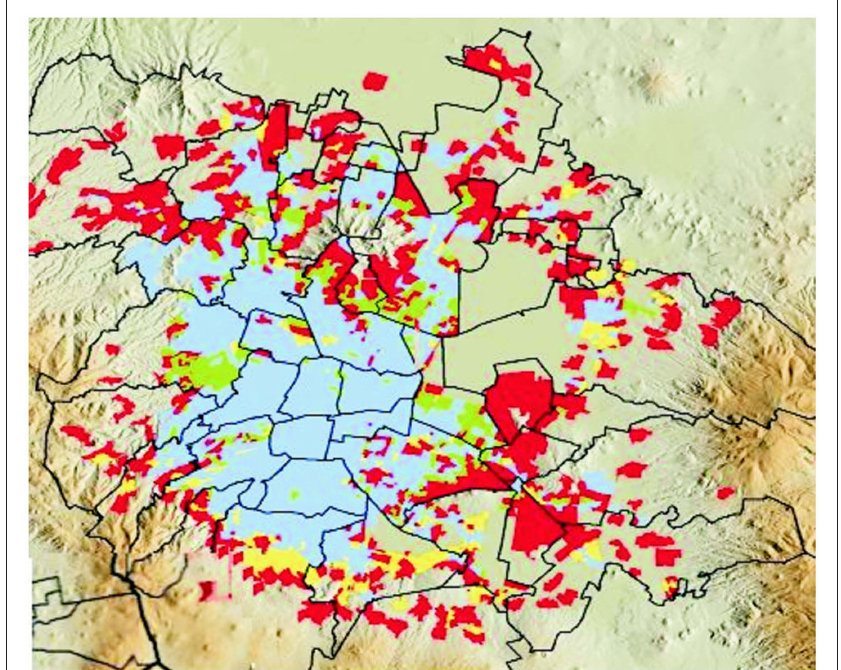
Figure 1 | Location of vulnerable population and housing groups in MC. Blue: not vulnerable; Green: vulnerable population; Yellow: vulnerable housing; Red: vulnerable population and housing. Population vulnerable areas have high concentration of people > 18 years without secondary education and low SES. Housing vulnerable groups live in areas of poor construction housing, without access to basic services, and limited property ownership/rights. The black line shows the limits of the Federal District. (Figure reproduced with permission from The World Bank,